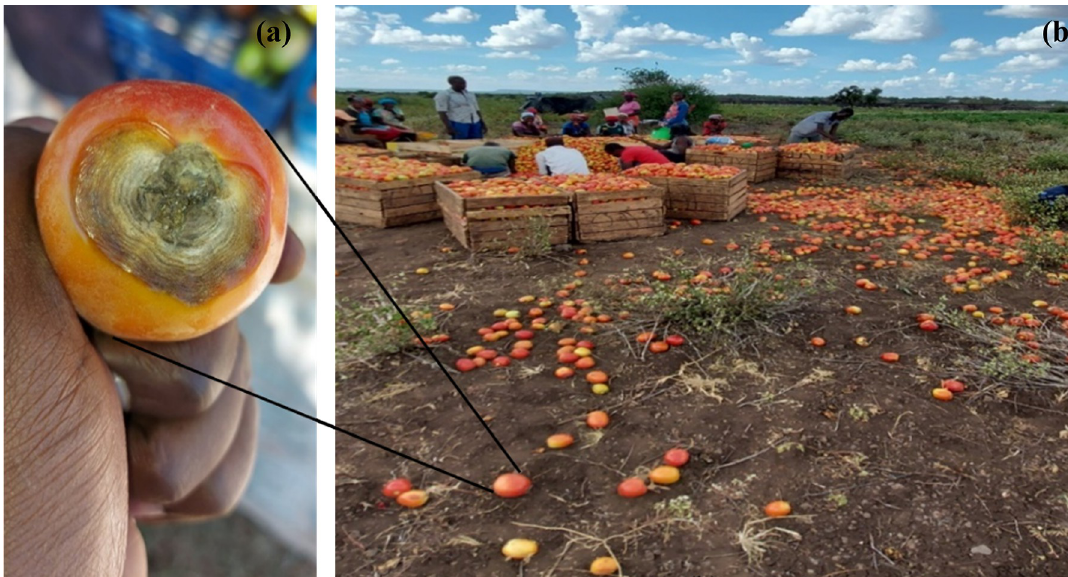
Fig 4. Typical early blight damage on a tomato fruit despite presence of fungicide residues (a) and large quantities of discarded damaged fruits (b). Approximately 30% of all harvested fruits were being discarded at this grading site in Gathigiriri village, Kirinyaga, County, Kenya